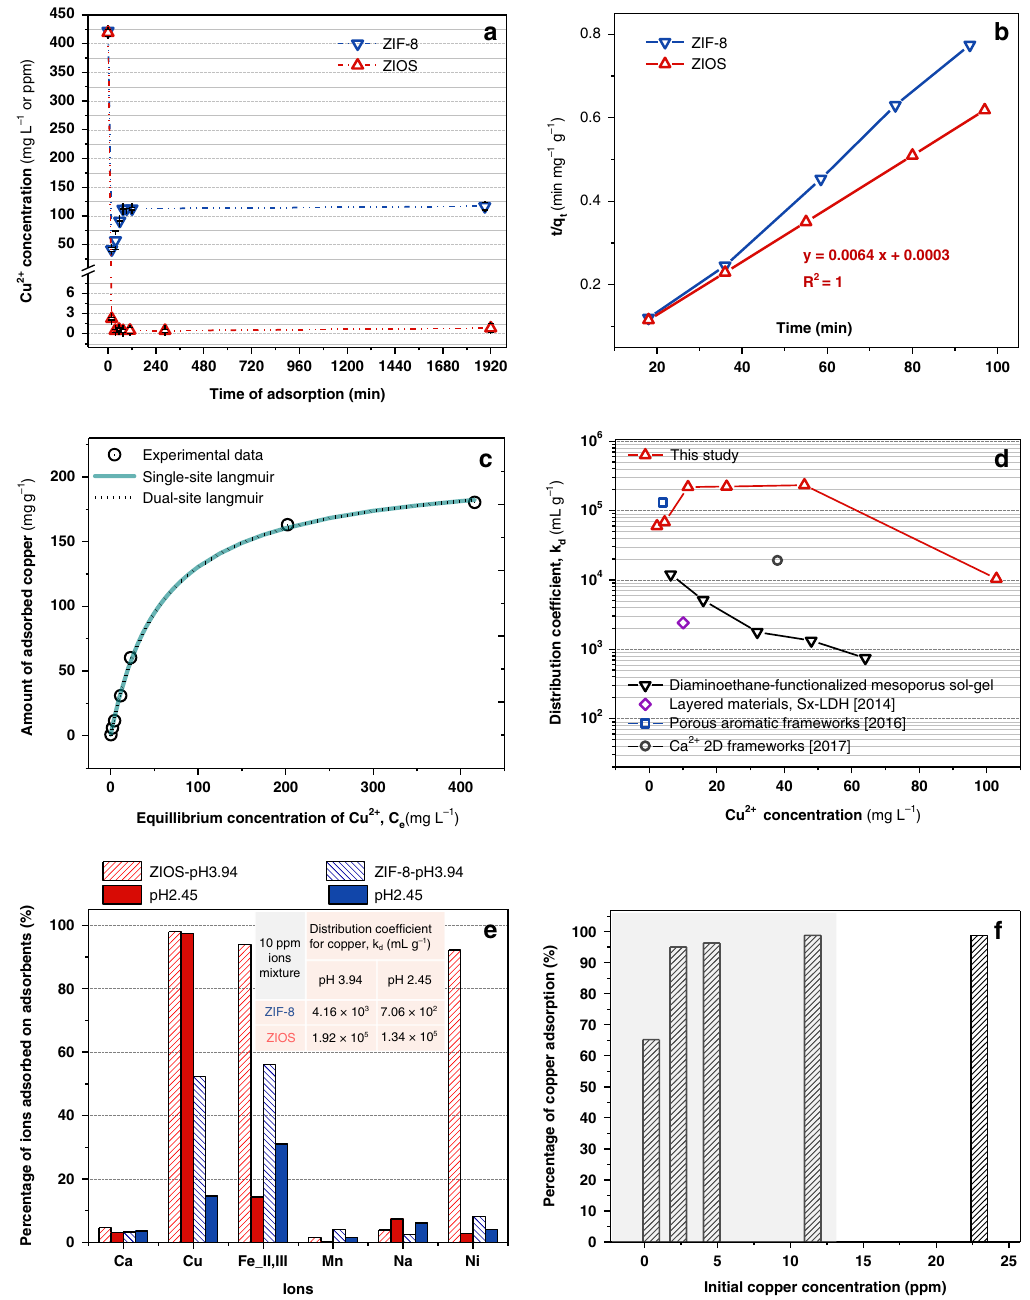
Fig. 3 Adsorption behaviors of ZIOS and ZIF-8. a , b Copper (II) ion adsorption kinetics collected on ZIF-8 and ZIOS (error bars were obtained from three different adsorption tests conducted on materials synthesized from random batches). c Experimental copper adsorption isotherm for ZIOS (symbols) shown with fi t using single-site (blue line) and dual-site (dotted line) Langmuir models. d Plots of distribution coef fi cients for ZIOS versus copper ion concentration (red triangles), compared with coef fi cients for other state-of-the-art copper ion adsorbents: a diaminoethane-functionalized mesoporous sol- gel (black triangles, ref. 12 ), double hydroxides intercalated with polysul fi des (purple diamond, ref. 32 ), PAF-1-SMe (blue square, ref. 5 ), and a Ca 2 + two- dimensional MOF (gray circle, ref. 71 ). e Copper selectivity of ZIOS and ZIF-8 when exposed to aqueous solutions (pH = 2.45 and 3.94) simultaneously containing equimolar concentration of Ca 2 + , Cu 2 + , Fe 2 + /Fe 3 + , Mn 2 + , Na + , and Ni 2 + (present as Cl − or NO 3 − salts). f Copper(II) adsorption data for ZIOS at low copper concentrations. Uptake of copper(II) in ZIOS at these trace levels is excellent: ~65% at 0.45 ppm Cu 2 + and ~95% at 2.5 ppm Cu 2 +